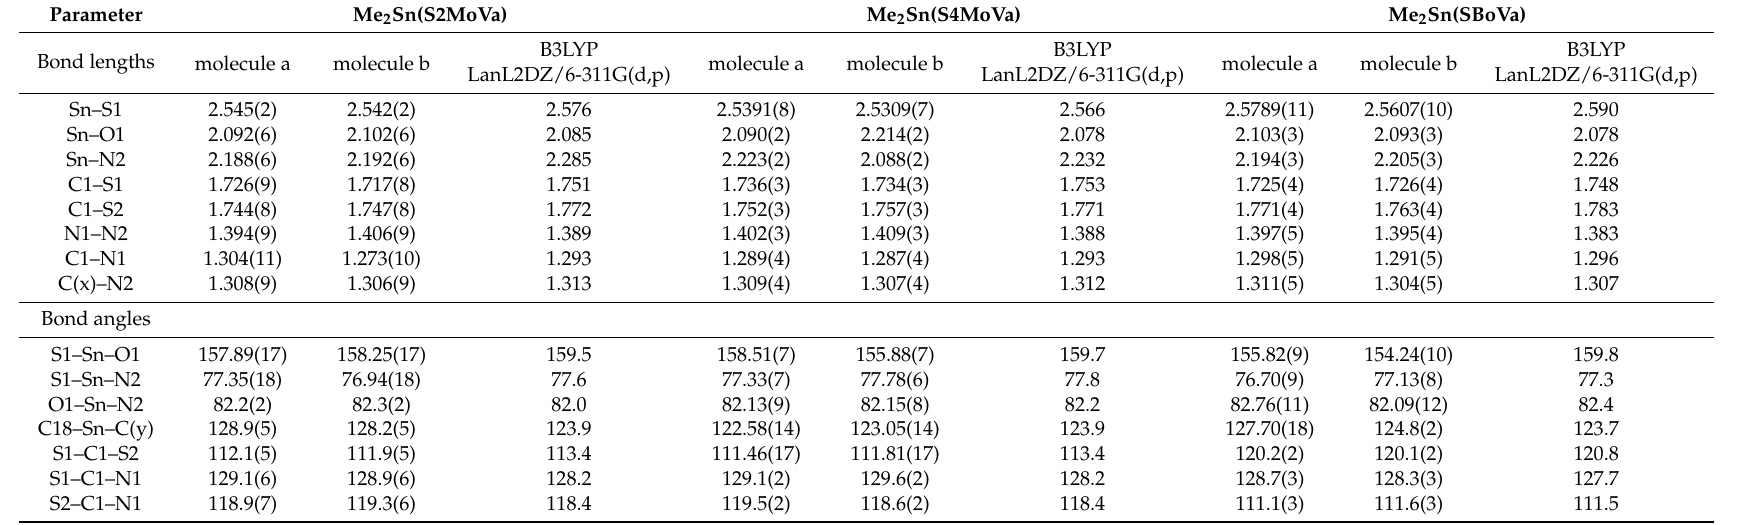
Table 1. Selected geometric parameters (Å, ◦ ) for Me 2 Sn(S2MoVa), Me 2 Sn(S4MoVa) and Me 2